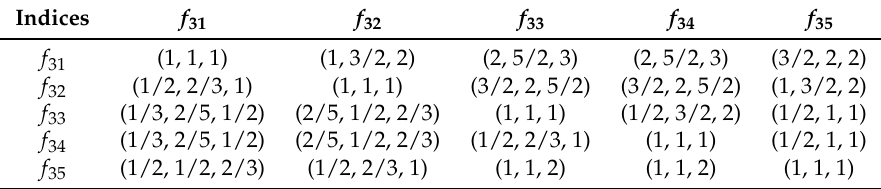
Table A3. Fuzzy comparison matrix of the indices of the electrical testing factor.